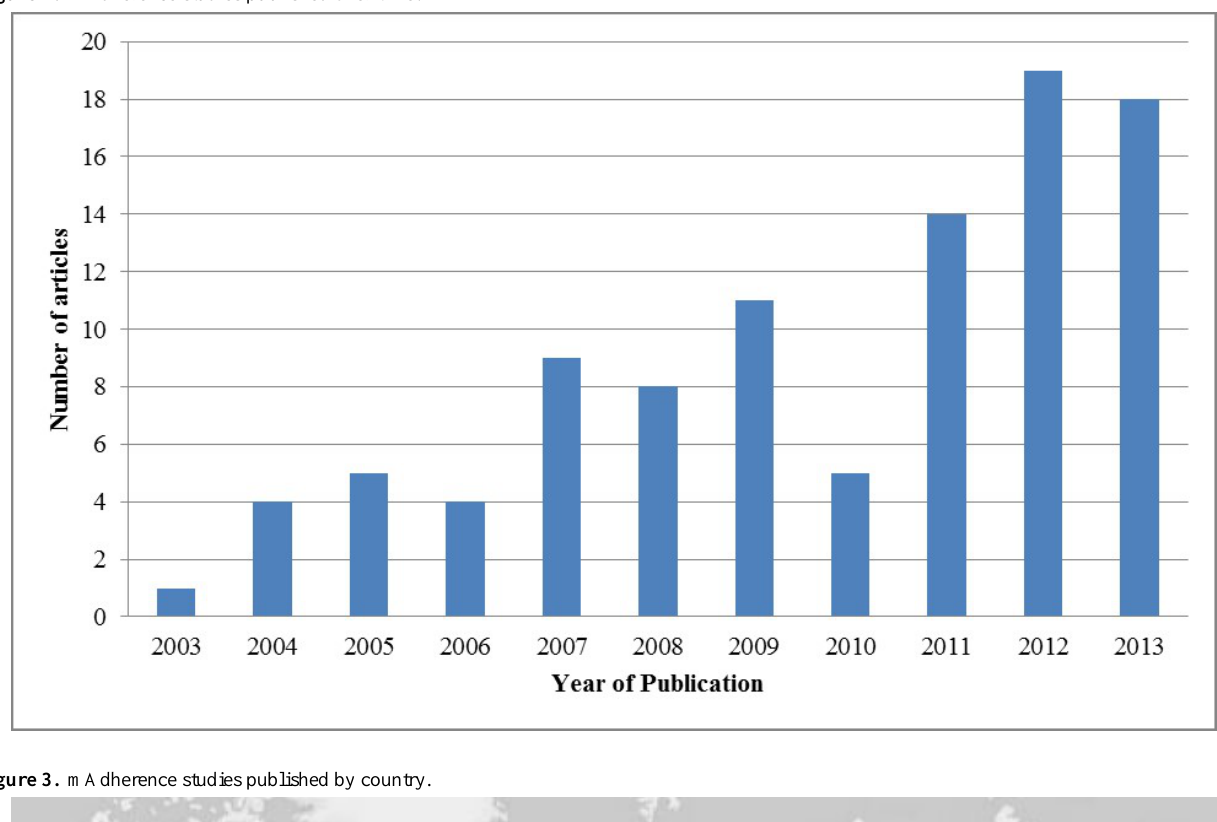
Figure 2. mAdherence studies published over time.